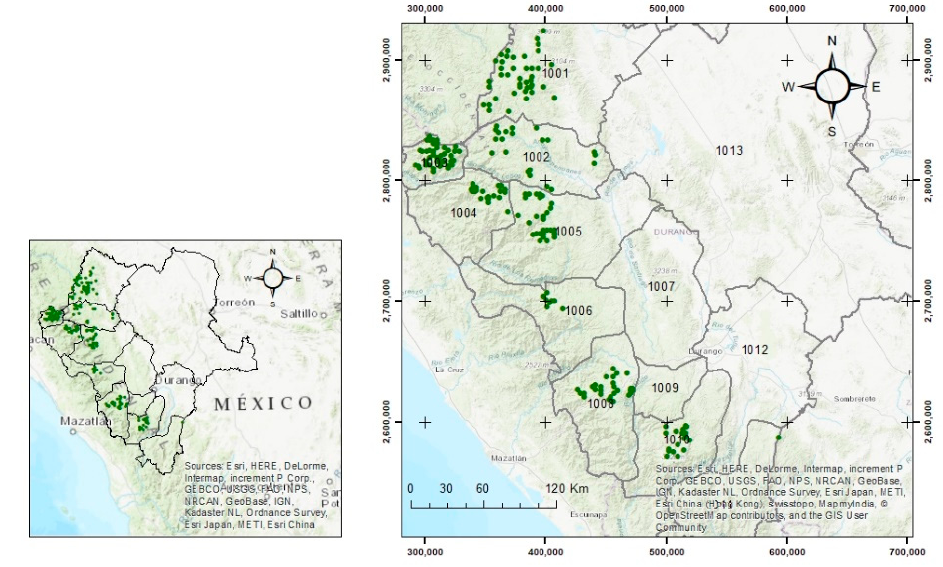
Figure 1. Study area, and location of 217 stem-mapped plots in Durango, Mexico (plot size is of 50 × 50 m).